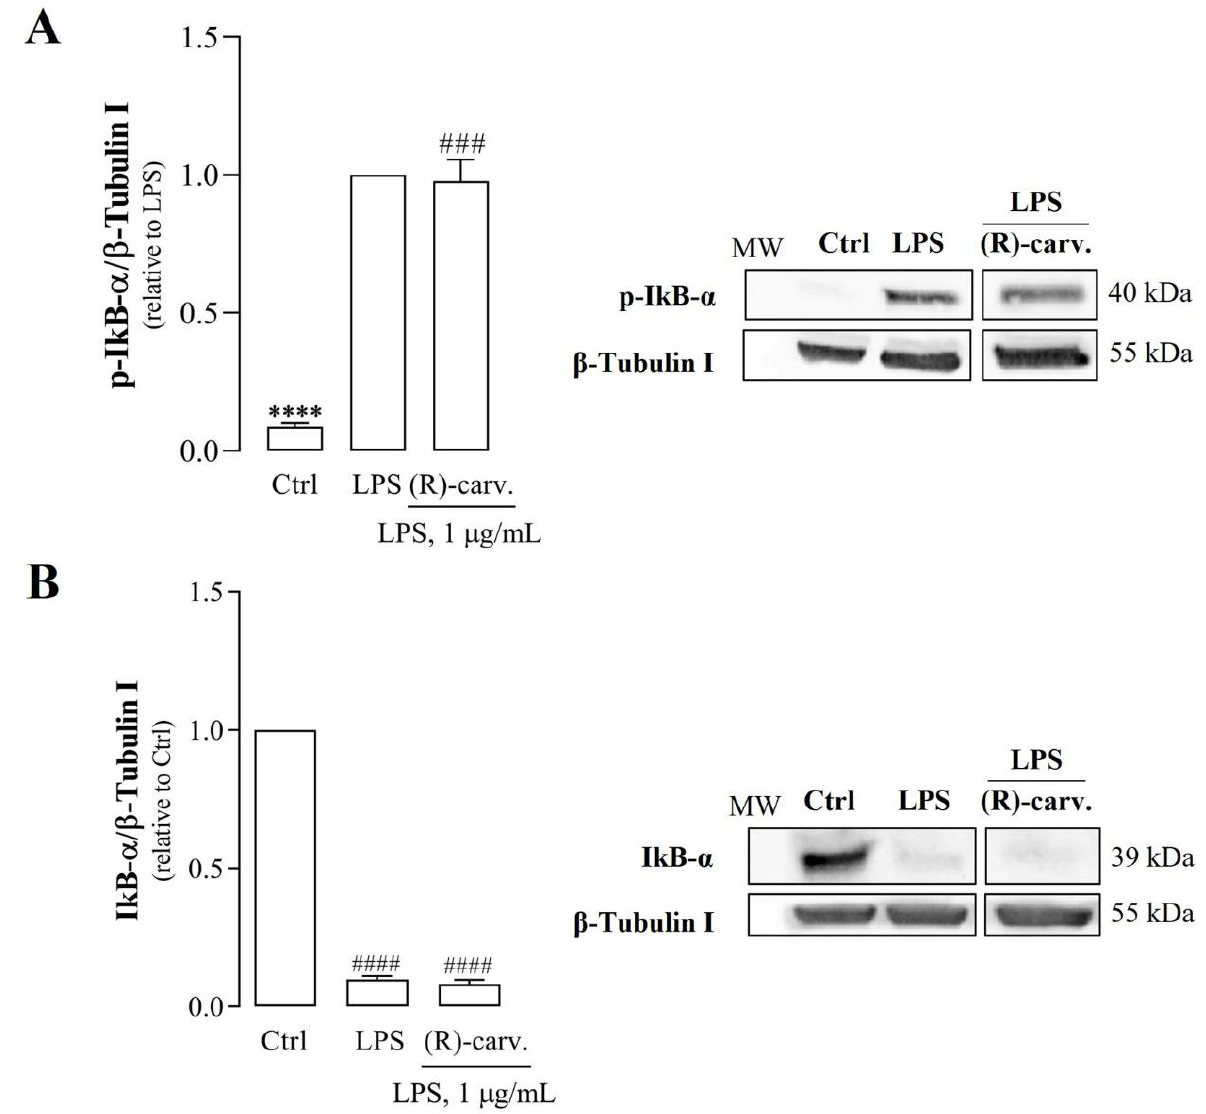
Figure 3. (R)-(-)-carvone does not affect the NF- κ B activation pathway, namely, phosphorylation ( A ) and degradation ( B ) of I κ B- α . Macrophage cultures were pre-treated with the vehicle (0.1% DMSO, Ctrl), or 665 µ M (R)-(-)-carvone for 1 h, followed by treatment with 1 µ g/mL LPS for 5 min ( A ) or 15 min ( B ). Each column represents the mean ± SEM of five ( A ) or four ( B ) independent experiments. Representative images are shown. The corresponding images of the full-length blots are shown in Supplementary Figure S1. **** p < 0.0001 relative to LPS-treated cells. ### p < 0.001 and #### p < 0.0001 relative to the Ctrl. MW: molecular weight